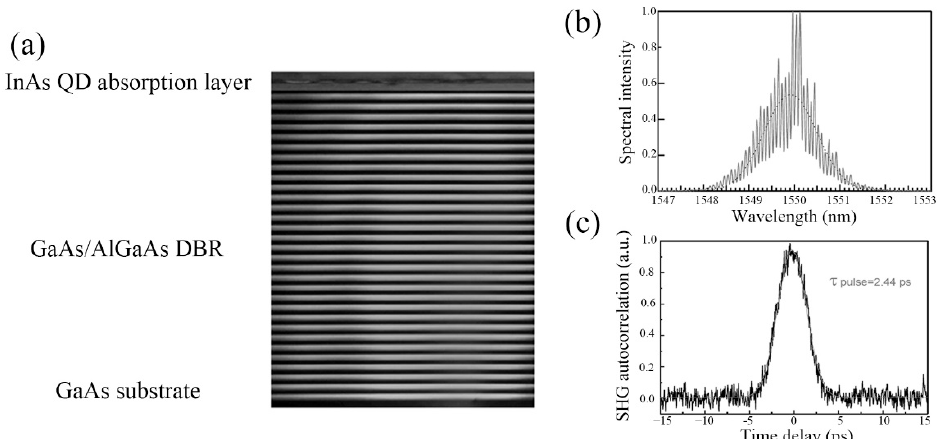
Figure 22. ( a ) TEM image of the 1.55 μ m QD-SESAM. ( b ) Laser output of optical power spectrum and ( c ) second harmonic generation autocorrelation trace. Reproduced with permission from [41]. Springer Nature, 2012.